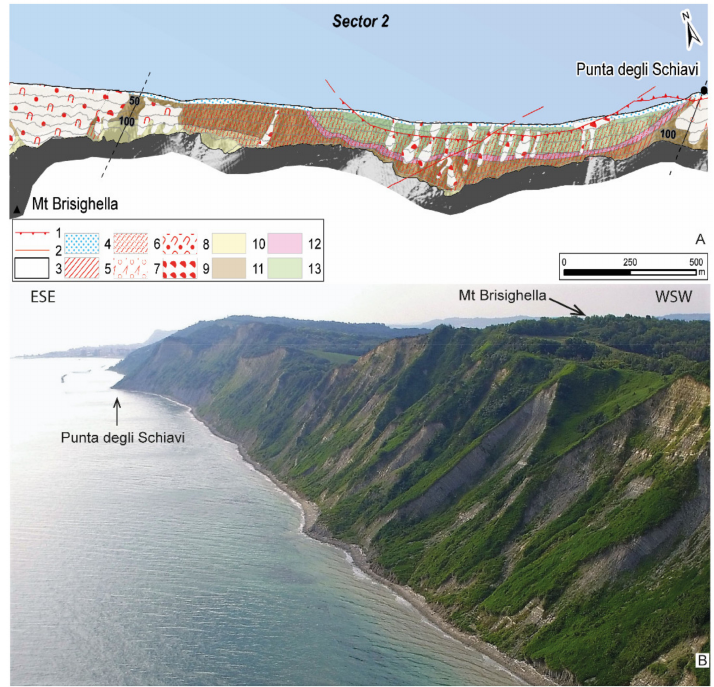
Figure 3. Sector 2 (Punta degli Schiavi–Mt. Brisighella) of the Mt. San Bartolo coastal slope. ( A ) Detailed geomorphological map: 1, Thrust fault; 2, Strike-slip fault; 3, Sector border; 4, Beach; 5, Landslide scarp; 6, Diffuse instability; 7, Slide; 8, Slump; 9, Flow; 10, Colombacci Formation; 11, San Donato Formation; 12, Gessoso Solfifera Formation; 13, Schlier Formation. ( B ) Panoramic view toward the